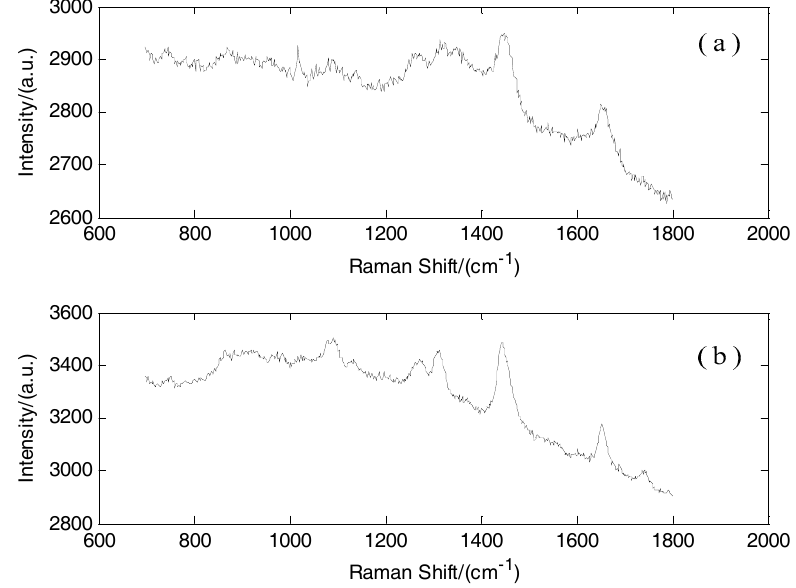
Figure 1. ( a ) Original Raman spectra of breast cancerous tissue without preprocessing; ( b ) Original Raman spectra of breast normal tissue without preprocessing.